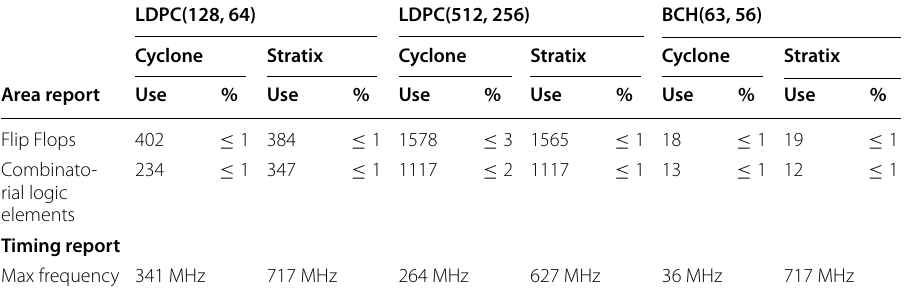
Table 6 LDPC and BCH encoders complexity and timing (maximum frequency) estimate